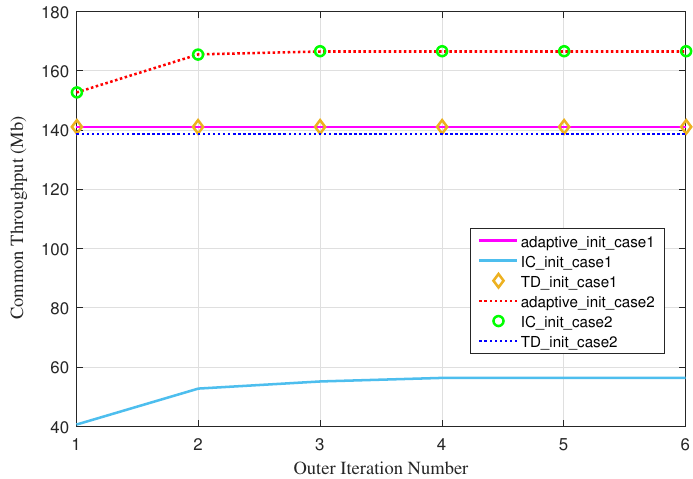
Figure 4. Convergence of the proposed algorithm in different cases.